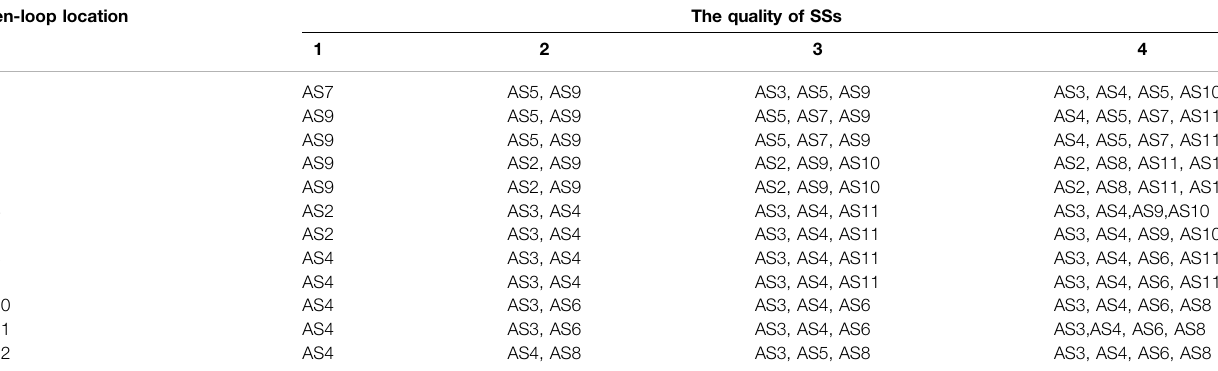
TABLE 12 | The installation for the 48